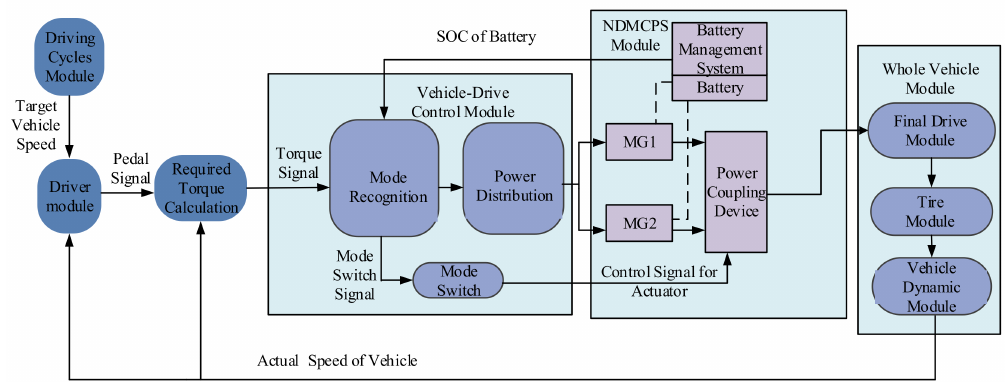
Figure 6. Simulation model for PEV equipped with NDMPS.